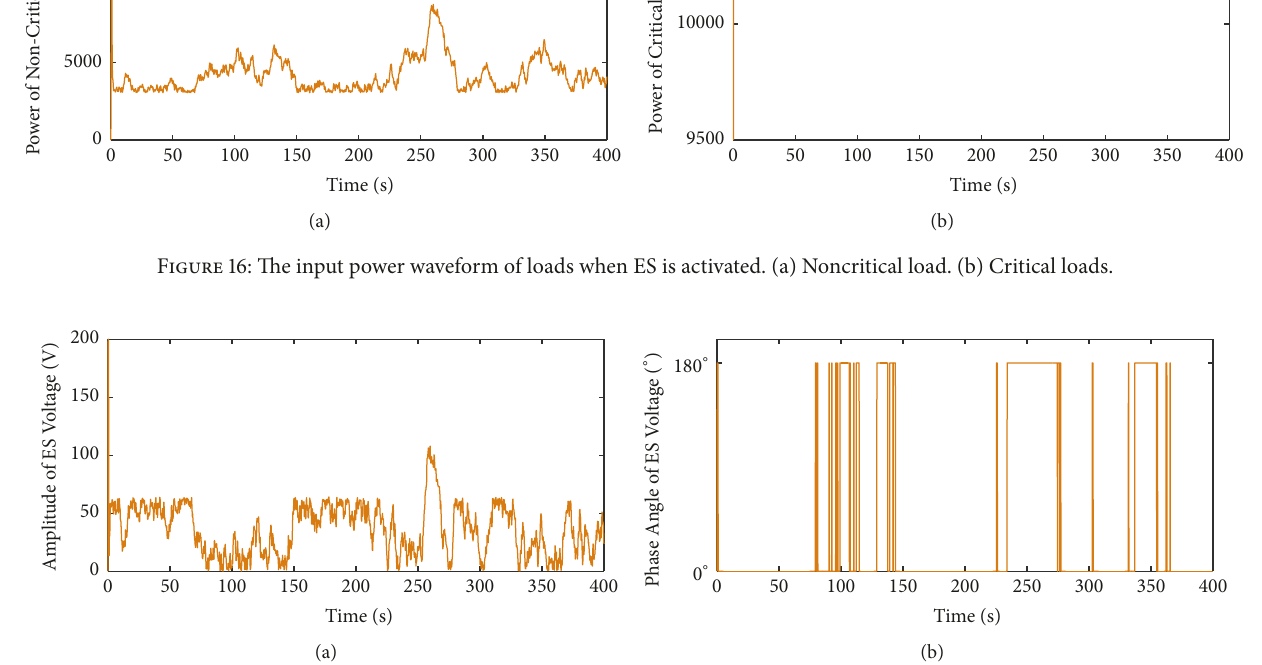
Figure 17: The amplitude and phase angle condition of ES voltage. (a) The amplitude of ES voltage. (b) The phase angle difference (0 ∘ or 180 ∘